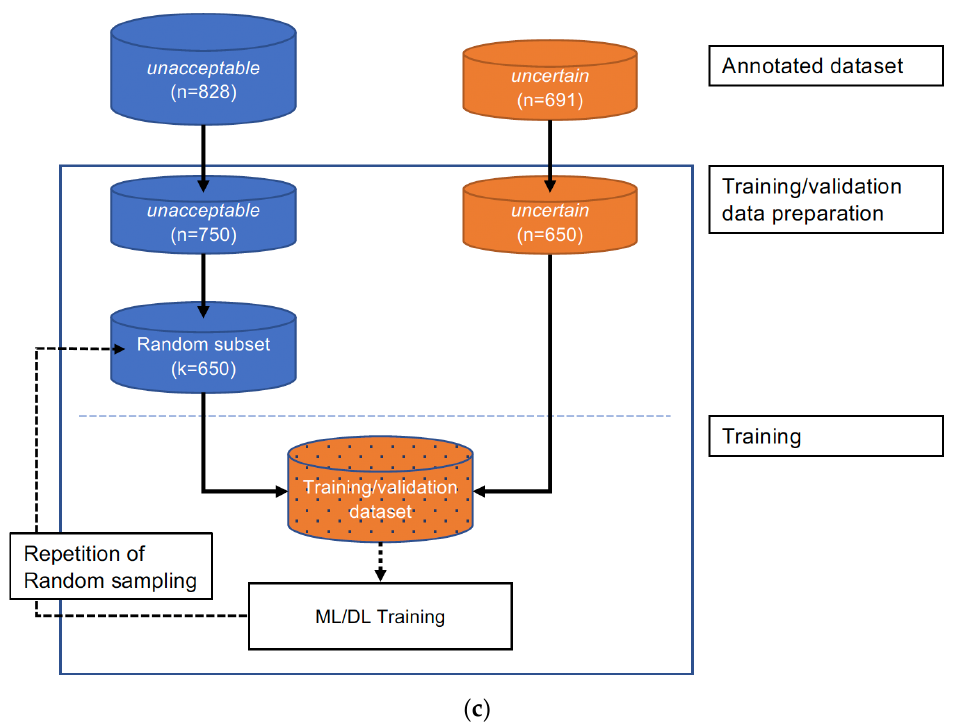
Figure 5. General training scheme of the three classi fi ers: ( a ) a 3-class classi fi er in the one-step approach; ( b ) the fi rst-step classi fi er in the two-step approach; ( c ) the second-step classi fi er in the two-step approach.